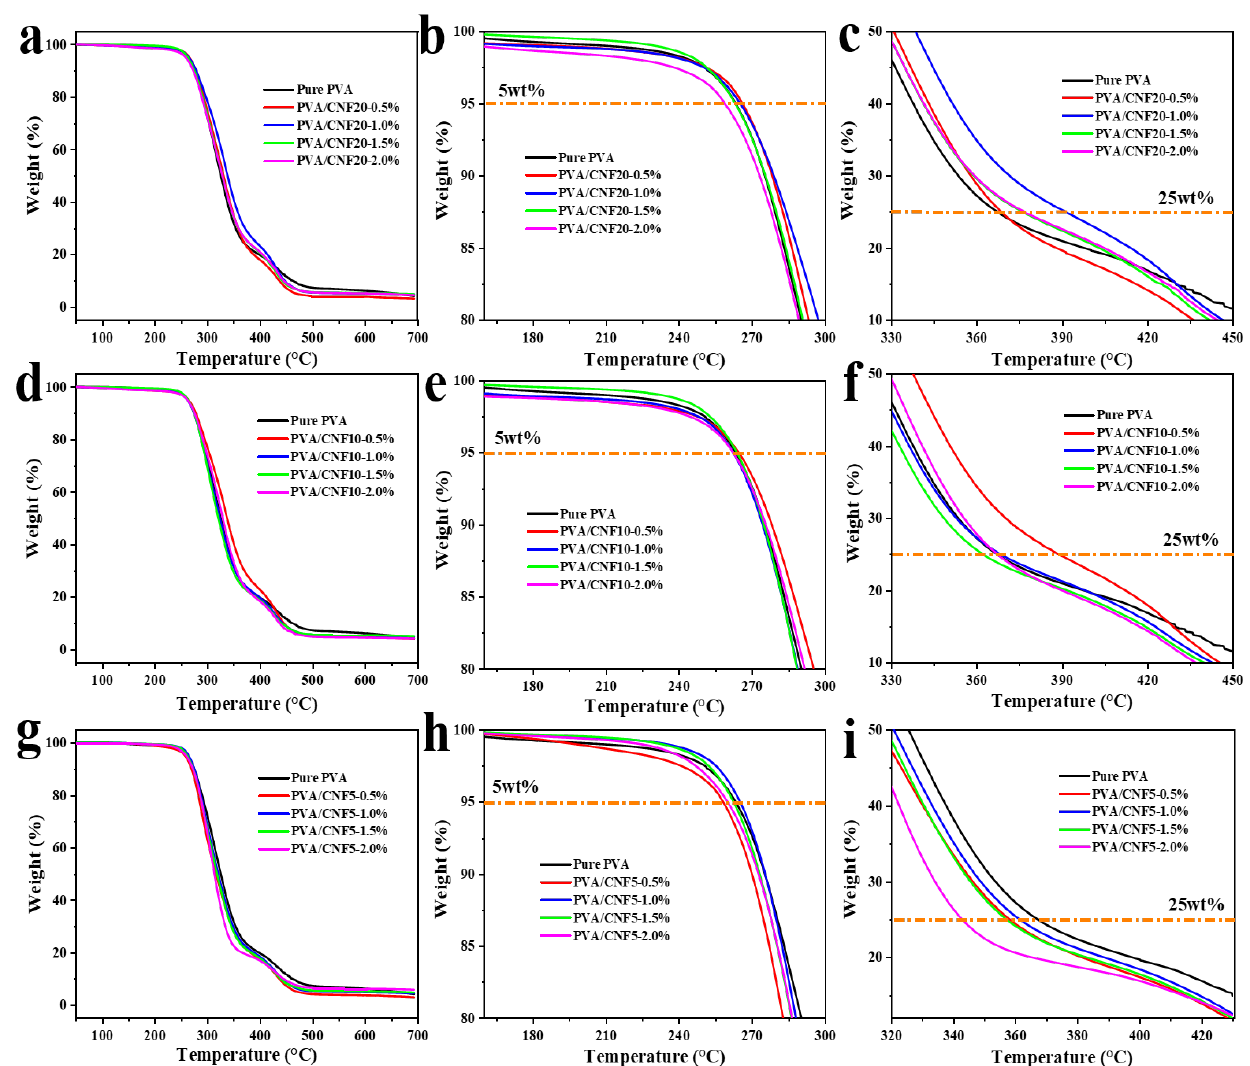
Figure 5. The TGA curves of ( a – c ) PVA/CNF20; ( d – f ) PVA/CNF10 and ( g – i ) PVA/CNF5 composites at a heating rate of 10 °C min −1 . Table 3. The TGA data of neat PVA and PVA/CNF composites as a function of the CNF content.